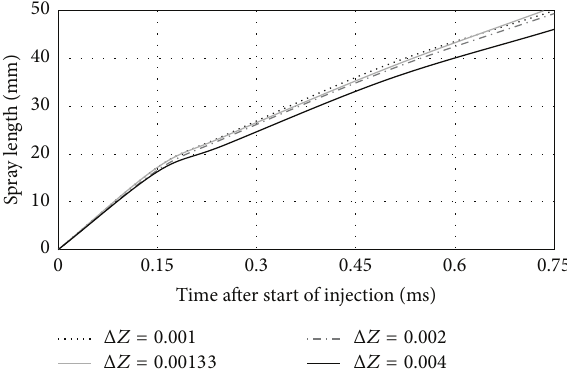
Figure 6: Resolution sensitivity analyses of HFO spray length at injection pressure of 1000